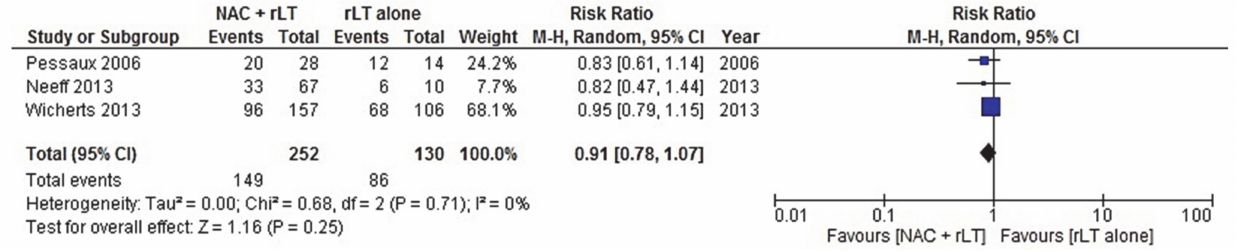
Figure 5. NAC + rLT versus rLT alone: five-year OS. Table 3. Outcomes, conclusions, and limitations for recurrent